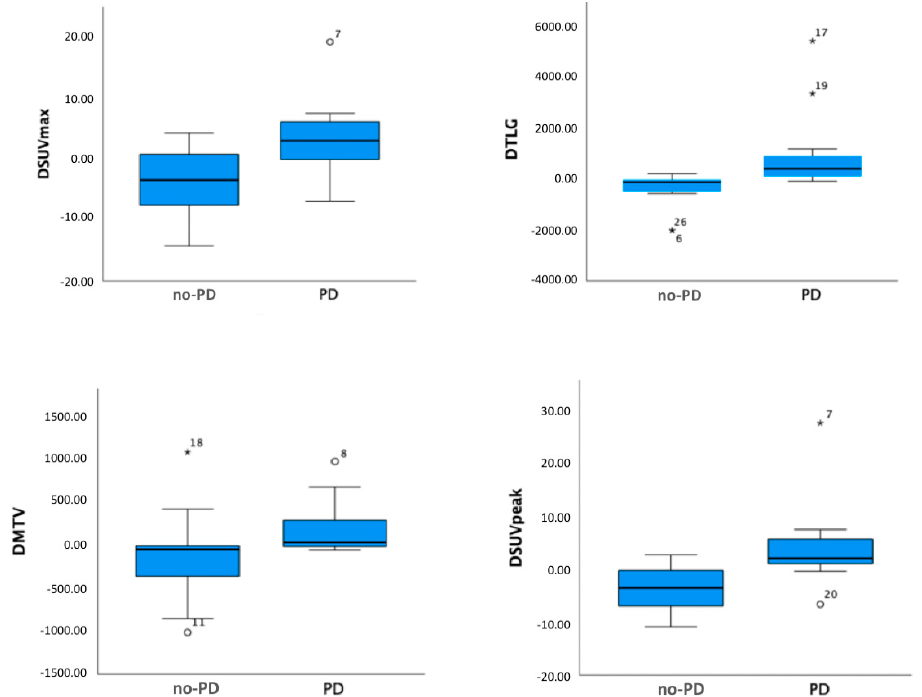
Figure 2. Box plots of PET-derived parameters which significantly correlated with progressive (PD) vs. non-progressive (no-PD) disease. CR: complete response; PR: partial response; SD: stable disease; PD: progressive disease; SUV: standardized uptake value; TLG: total lesion glycolysis; MTV: metabolic tumor volume.The midline, box edges and outers bars indicate the median, first and third quartiles, and the upper and lower whiskers, respectively. Dots ( ◦ ) and asterisks (*) represent outliers.